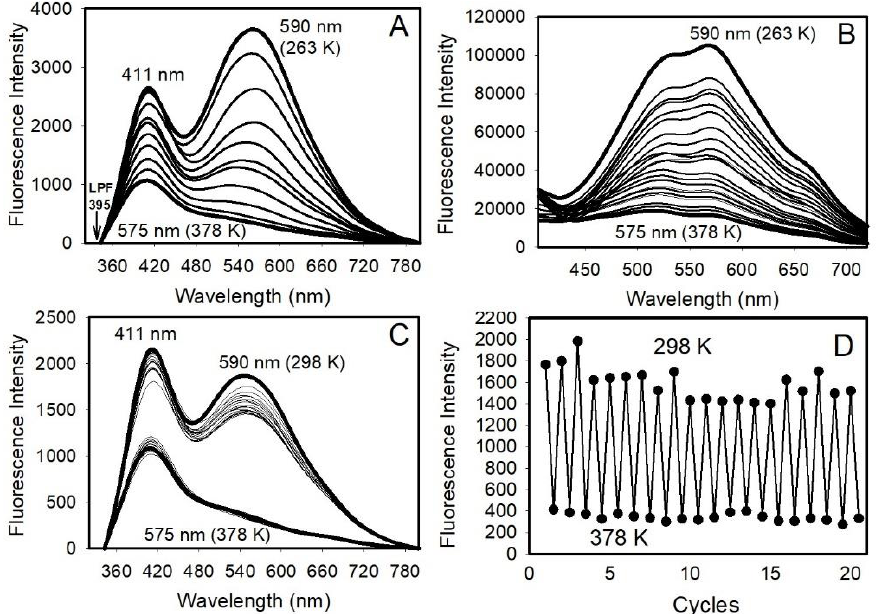
Figure 3. Photoluminescence (PL) spectra upon excitation at 320 nm ( A ) and 375 nm ( B ) at different temperatures from 263 to 378 K; ( C ) the data generated in several cycles from 298 to 378 K; ( D ) the corresponding plot monitored at 590 nm. Notably, the peak at 385 nm appeared at 411 nm because of the use of a long pass filter at 395 nm.